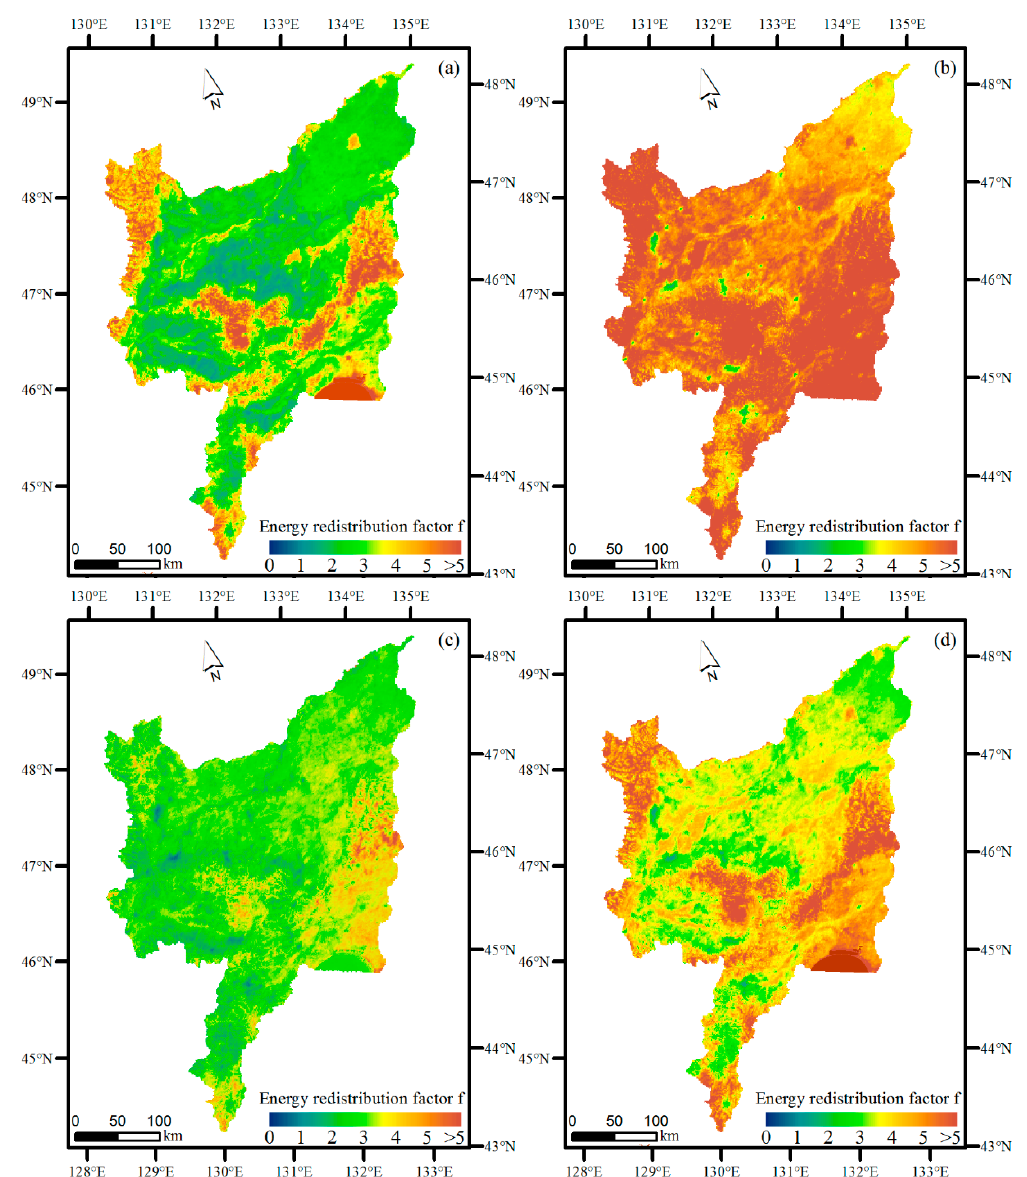
Figure 4. Spatial distribution of the energy redistribution factor f in spring ( a ) (May and June), summer ( b ) (July and August), autumn ( c ) (September), and the growing season ( d ) (May to September) in the Sanjiang Plain. The growing season is from May to September, which was divided into three seasons according to the characters of Figure 3. The f values for the whole Sanjiang Plain was estimated based on 2006–2015 monthly mean climatologies of the net apparent heat flux, soil heat flux, air temperature, surface temperature, and surface albedo in each 1 km × 1 km pixel.